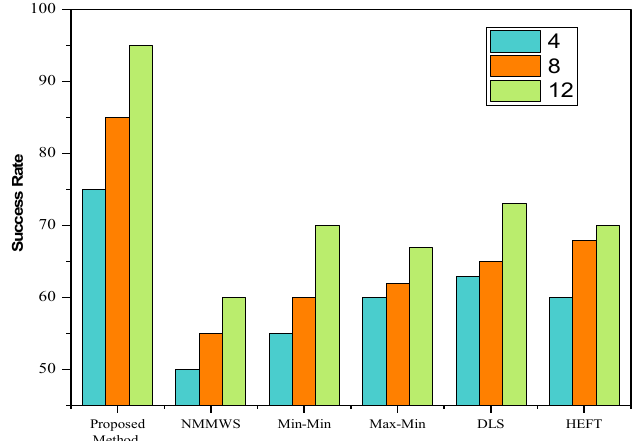
Figure 17. Success rate on the LIGO workflow.